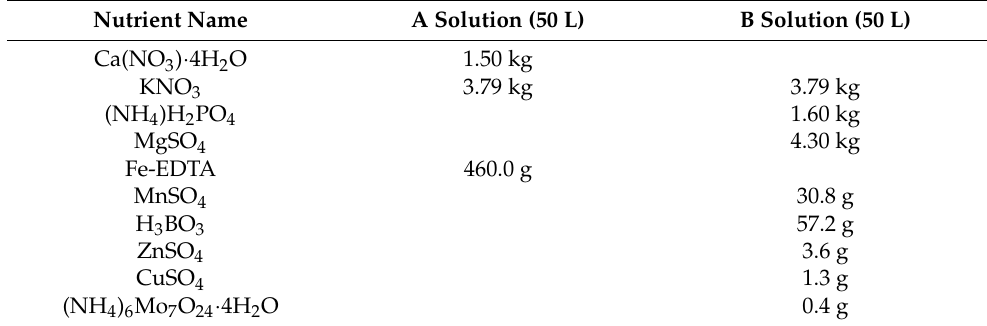
Table 1. Nutrient solution composition.